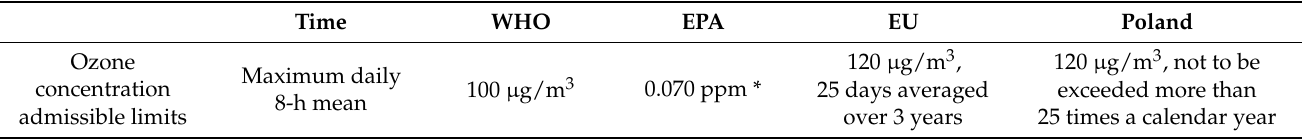
Table 2. Ozone concentration standards (in µ g/m 3 ) based on national and EU legislation, WHO and EPA recommendation. Time WHO Ozone concentration admissible limits